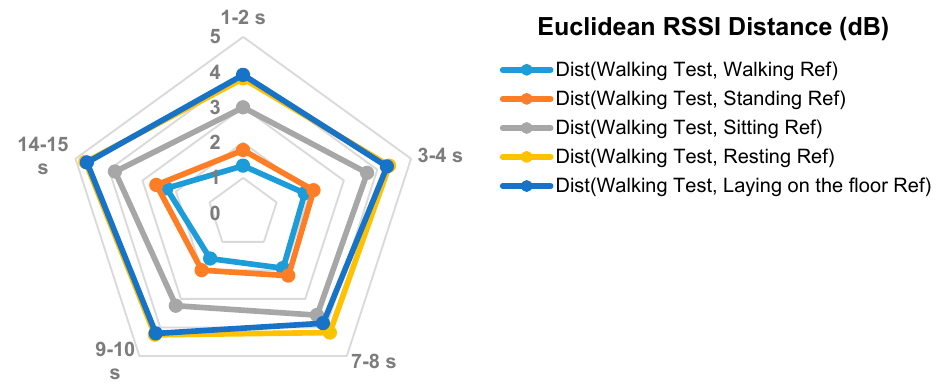
Figure 4. System performance for walking position within the measured time.